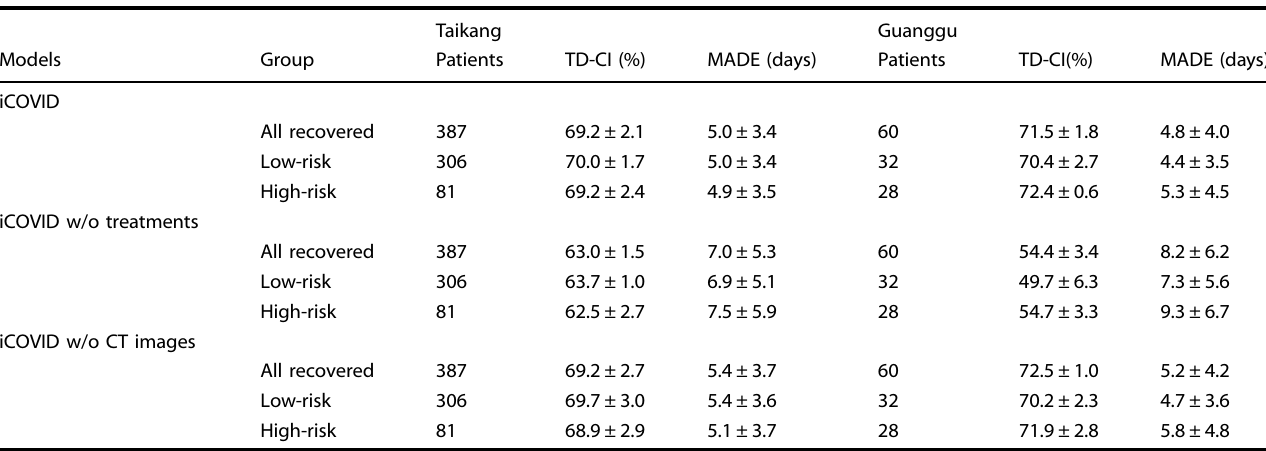
Fig. 7 Comparison across different survival models. a – c Time-dependent AUC scores of iCOVID, Cox ’ s proportional hazard (CPH) model, and random survival forest (RSF) model. The curves demonstrate that the proposed iCOVID model can achieve superior performance over both the CPH and RSF models regardless of whether treatment or image are considered. Table 2. External validation results of fi vefold cross-validation